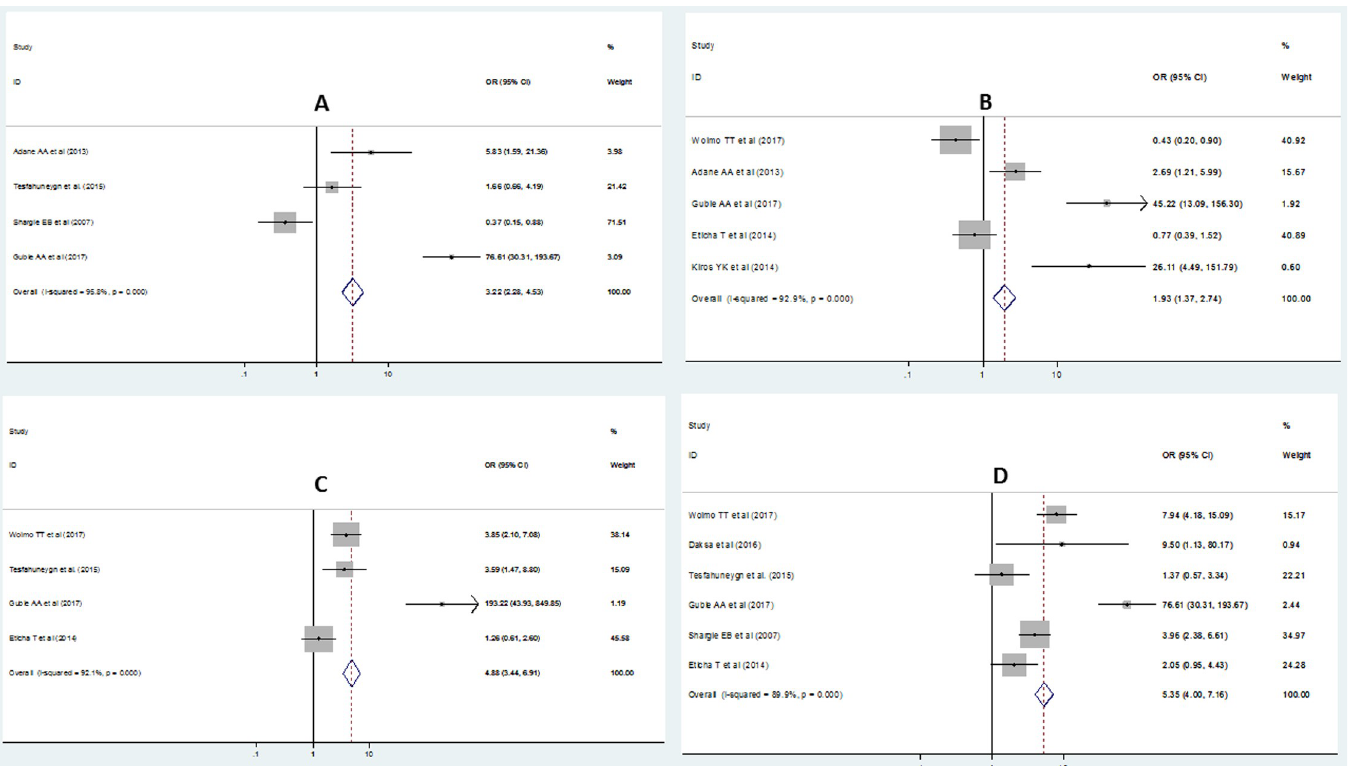
Fig 5. Forest plot depicting pooled odds ratio (log scale) of the associations between non-adherence to Anti TB medication and its purported determinants (A: forgetfulness B: fear of side effect of drugs C: long waiting time in health institution D: feeling distance to health institution is long).